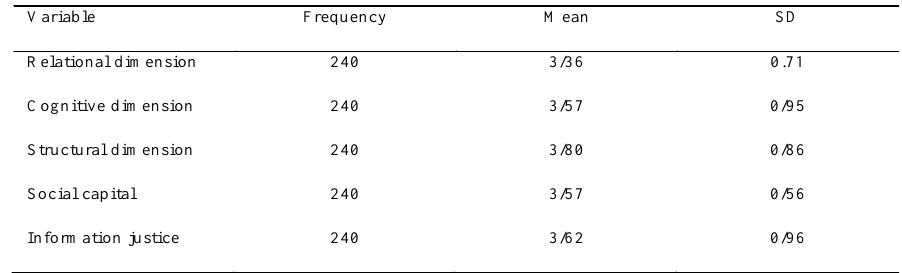
Table 2: Mean and standard deviation of research